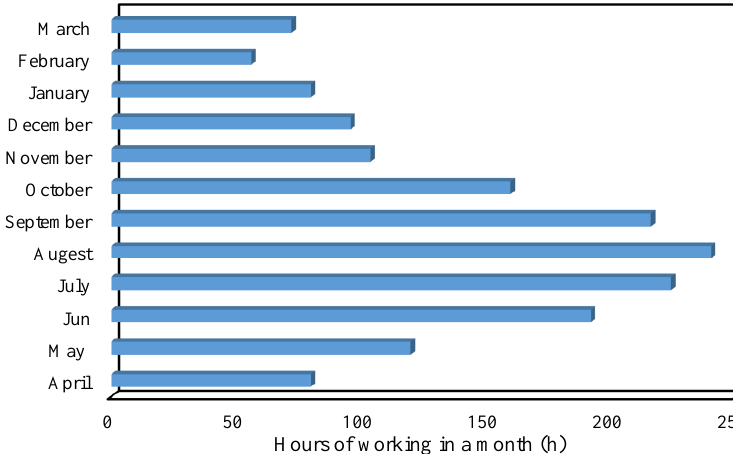
Fig. 2. The total number of working hours per month in Mashhad